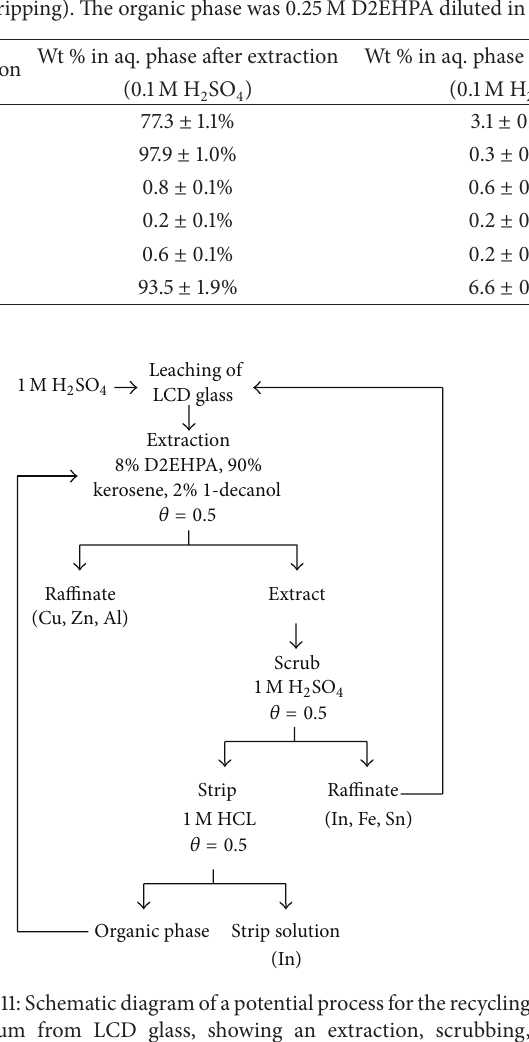
SO (extraction and scrubbing) and 1M 2 4